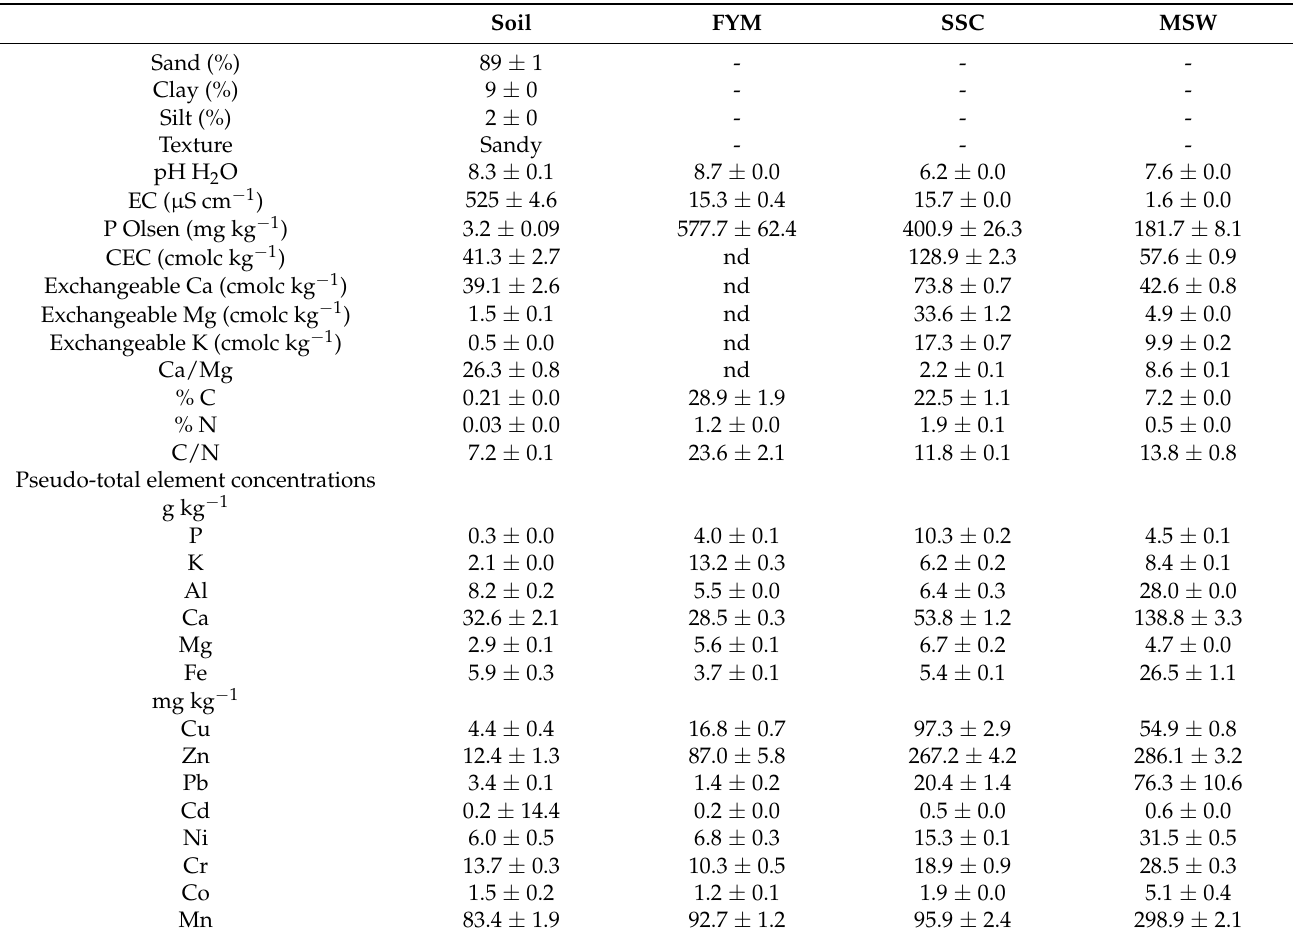
Table 1. Some physicochemical characteristics of the soil and of the three types of organic amendments used (farmyard manure, FYM; sewage sludge compost, SSC, and municipal solid waste compost,